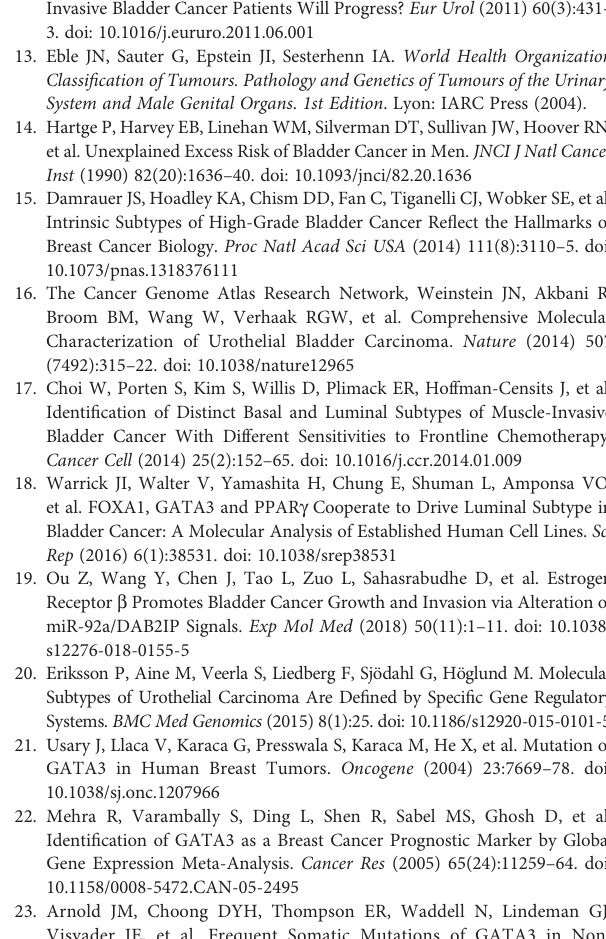
Supplementary Figure 2 | Funnel plots showing the asymmetry and publication bias for ER a , ER b and GATA3. Supplementary Figure 3 | Forest plot showing pooled results for ER a positive expression in bladder cancer samples. Supplementary Figure 4 | Baujat plots comparing the weight of each study to the overall heterogeneity for ER a (A) , ER b (B) and GATA3 (C) . Supplementary Figure 5 | Forest plot showing the pooled results for ER b positive expression in bladder cancer samples. Supplementary Figure 6 | Forest plot showing the pooled results GATA3 positive expression in bladder cancer